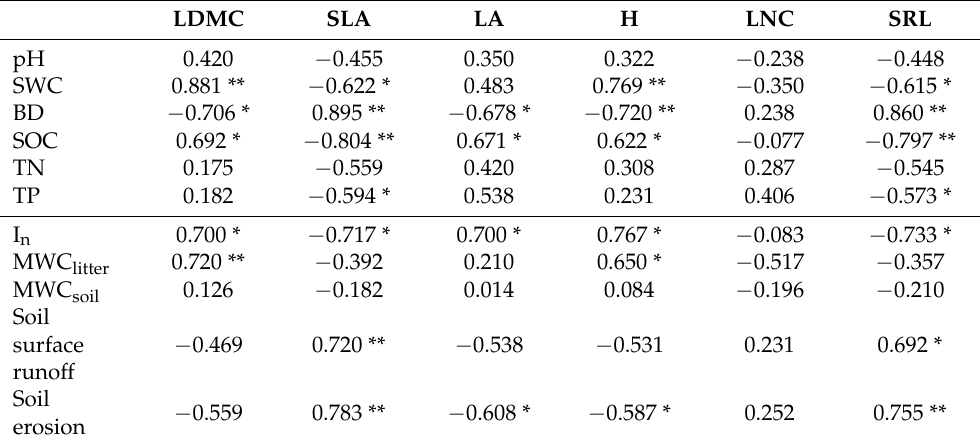
Table 2. Spearman correlations between plant traits and soil basic physicochemical properties and ecosystem function parameters.